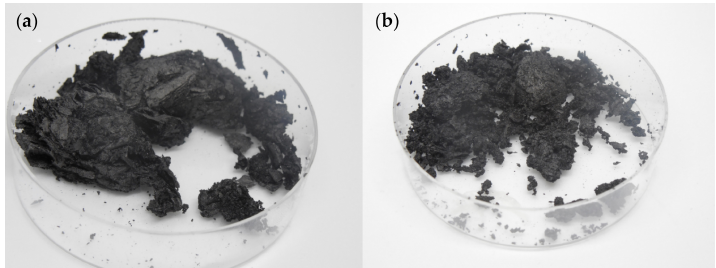
Figure 1. ( a ) Reduced graphene (rGO) oxide with manganese dioxide (MnO 2 ) nanocomposite and ( b ) after functionalization with ascorbic